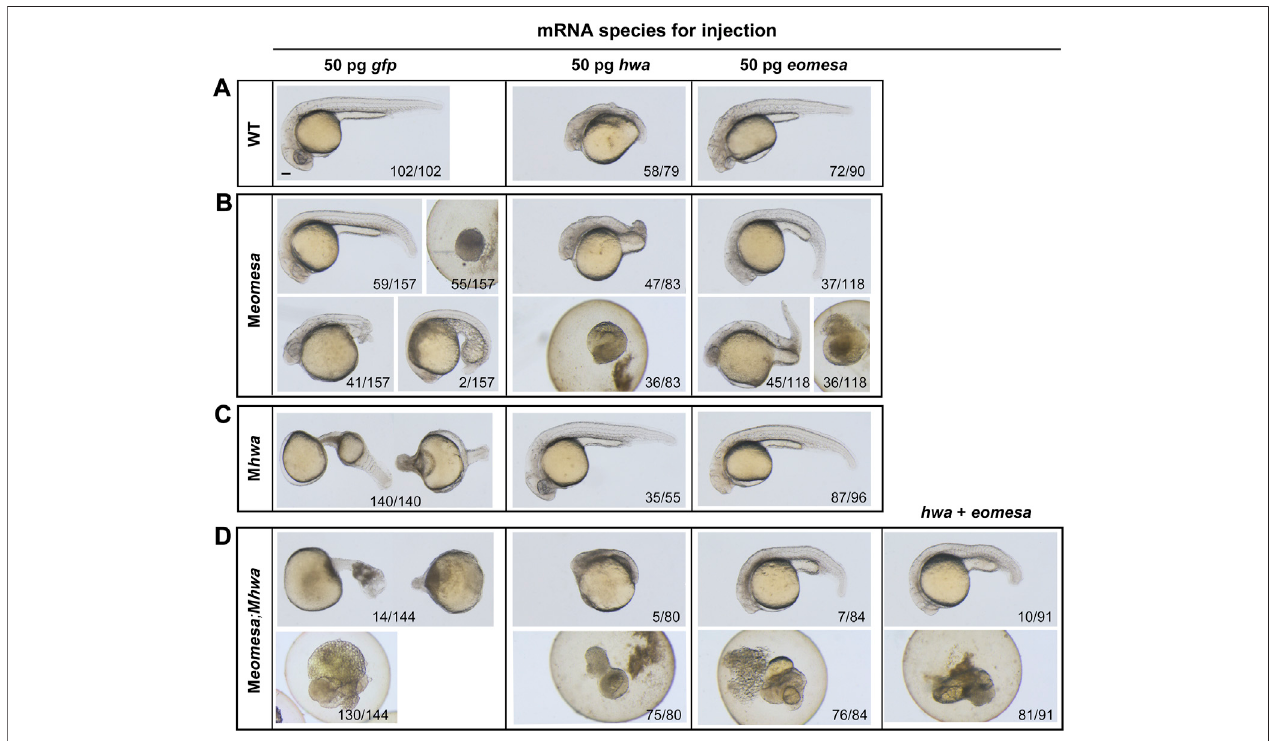
FIGURE4| Overexpressioneffectof eomesa and hwa inWTanddifferenttypesofmutantembryosonmorphologicalchangesat24hpf. (A – D) MorphologyofWT or mutants at 24 hpf under different mRNAs injection. One-cell stage WT or mutant embryos were injected with corresponding mRNA and observed for morphology at 24hpf.Embryoswerepositionedlaterallywiththeheadtotheleft.Theratioofembryoswiththerepresentativepatternwasindicatedatbottom.Injectiondoses: hwa and myc-eomesa , 50 pg/embryo. Scale bars: 100 μ m.